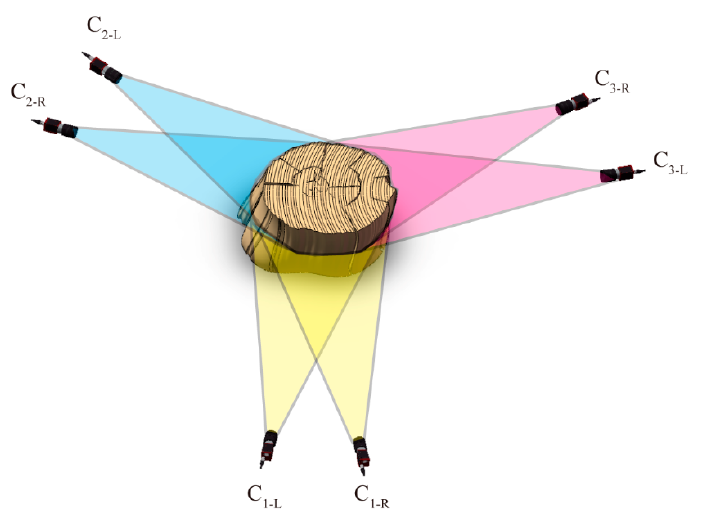
Figure 1. 360-deg six-camera measurement system schematic. A circular array of three stereo-camera pairs surrounding the object to be measured and the field of view (FOV) of each stereo camera pair exceeds 120 degrees.